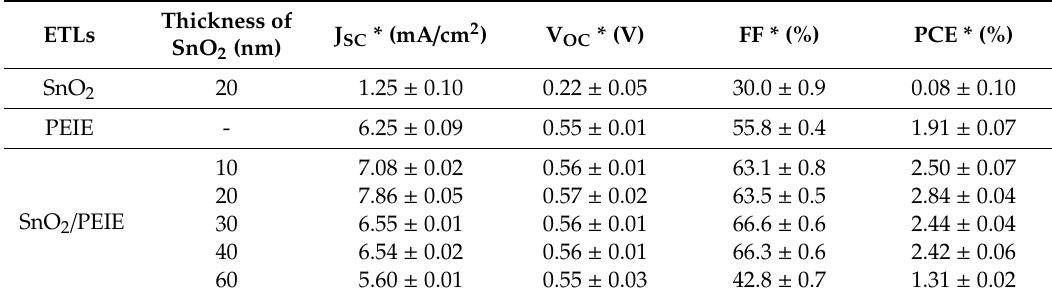
Table 2. Characteristics of P3HT:PCBM-based bulk heterojunction devices with di ff erent electron transporting